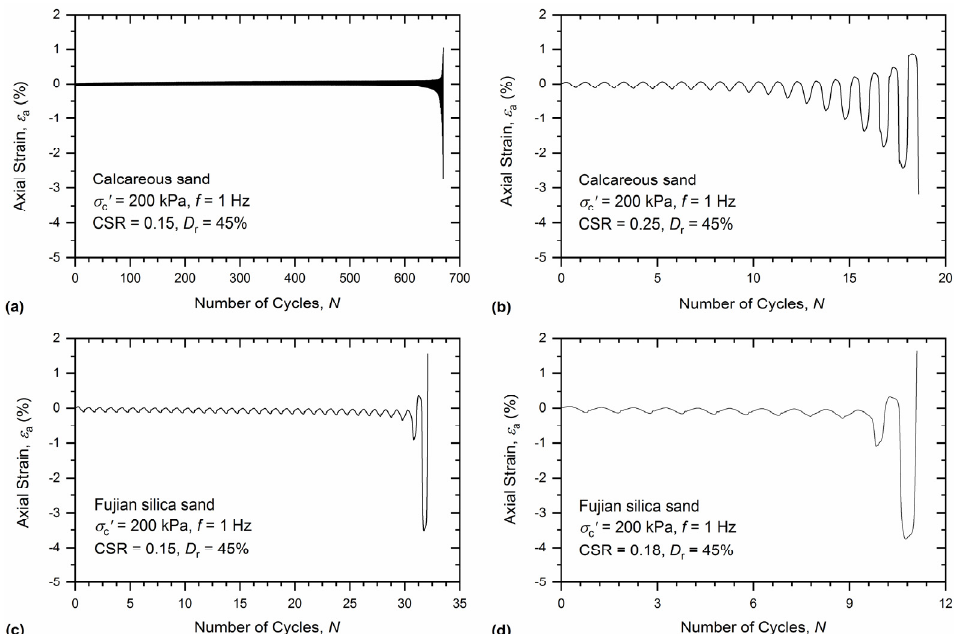
Figure 7. Axial strain versus number of cycles for the specimens under σ (cid:48) c = 200 kPa and D r = 45%: ( a ) calcareous sand with CSR = 0.15, ( b ) calcareous sand with CSR = 0.25, ( c ) Fujian silica sand with CSR = 0.15, ( d ) Fujian silica sand with CSR = 0.18.